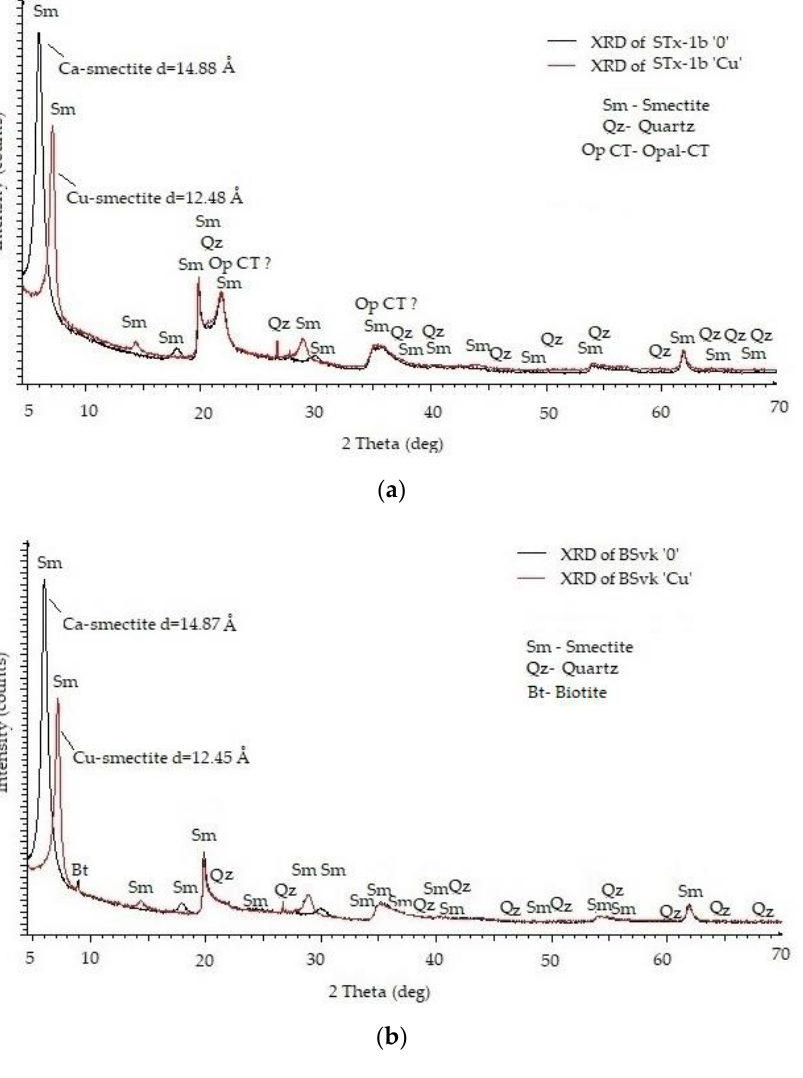
Figure 2. Powder XRD patterns of the bentonite samples before ‘0’ and after ‘Cu’ treatments ( a ) Stx-1b from Texas, ( b ) BSvk from